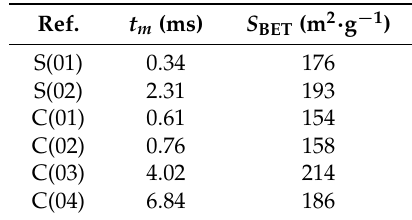
Table 3. BET surface area of MnO 2 precipitated in varying types of C-CFMCR. Ref.